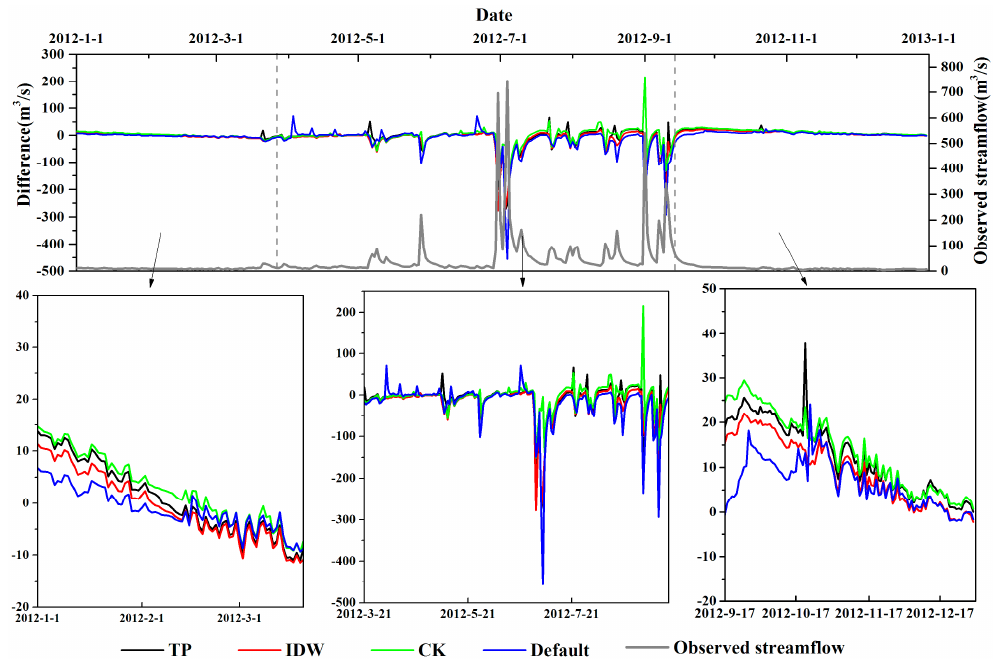
Figure 3. Modeled streamflow difference between various methods and the observed streamflow at Wenquan gauging station.